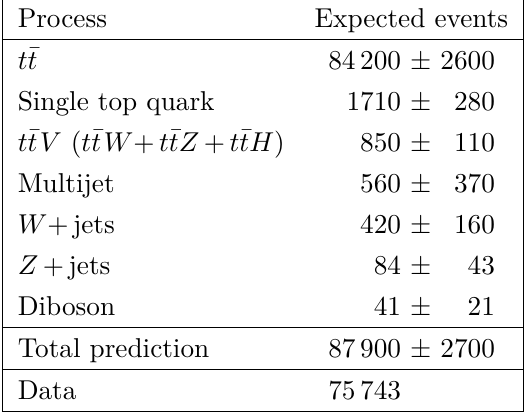
Table 1. Event yields for measured data, simulated t ¯ t signal and background events. The uncer- tainty values are symmetrised and indicate the combined effect of statistical, detector and back- ground modelling